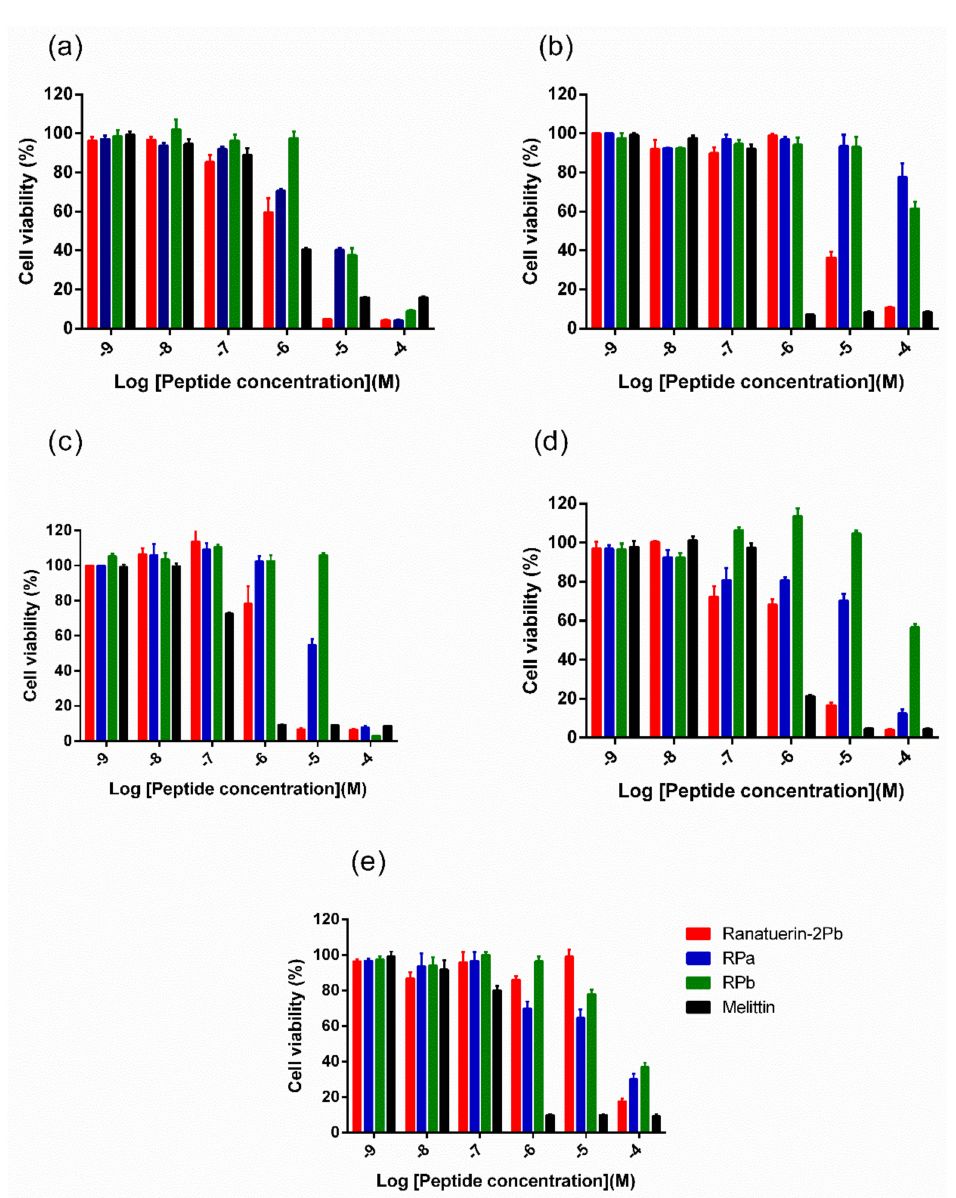
Figure 6. The e ff ect on cell proliferation of peptides on the cancer cell lines ( a ) NCI-H157, ( b ) MCF-7, ( c ) U251MG, ( d ) PC-3 and ( e ) MDA-MB-435s. Ranatuerin-2Pb, RPa, RPb and Melittin are labelled red, blue, green and black, respectively. The 100% cell viability was applied with growing cells without peptide treatment. Data points represent the average of three independent experiments with error bars presenting the